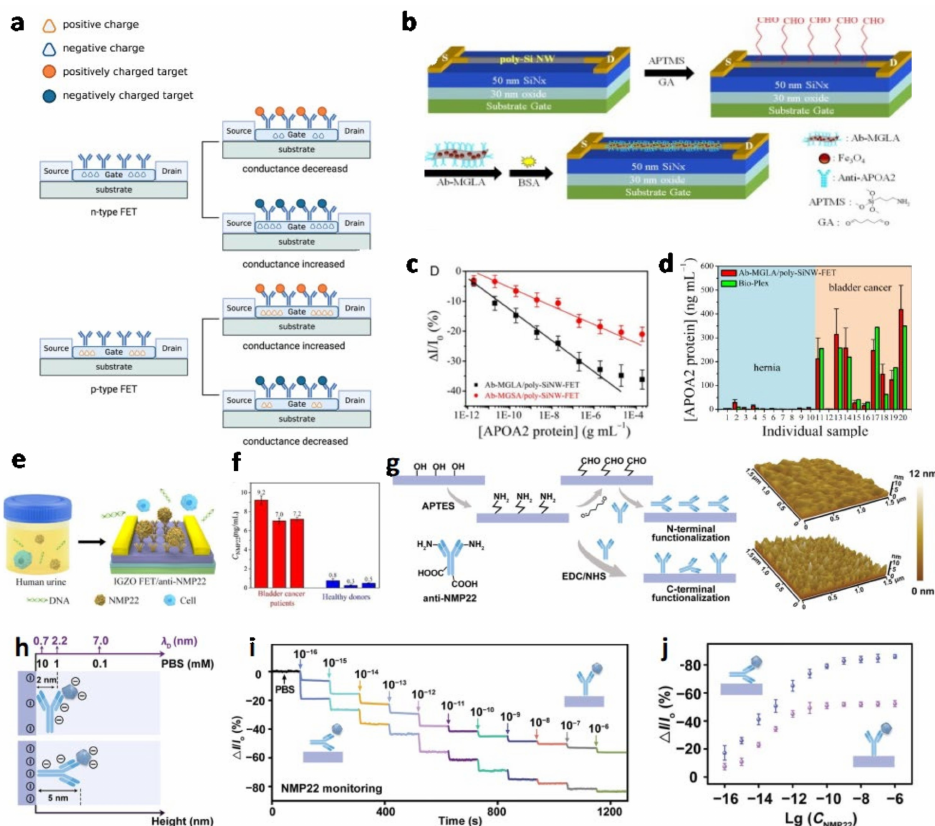
Figure 4. ( a ) The principle of the bio-FET for target biomarker detection (Created with biorender.com). ( b ) The schematic of the preparation of Ab-MGLA/poly-SiNW-FET biosensor reported by Chen et al. ( c ) The calibration curves of the current responses of the poly-SiNW-FET biosensor modified by MGLA and MGSA. ( d ) APOA2 protein concentrations in hernia and BC patients’ urine samples based on Bio-Plex (green bars) and Ab-MGLA/poly-SiNW-FET (red bars). (Reprinted with permission Ref. [22]. Copyright © 2014 Elsevier B.V.) ( e ) Schematic of the BC biomarkers detection with IGZO- FET biosensor. ( f ) Sensing performance evaluation of anti-NMP22/IGZO-FET biosensors towards BC patients’ and healthy donors’ urine samples. (Reprinted with permission Ref. [48]. Copyright ©